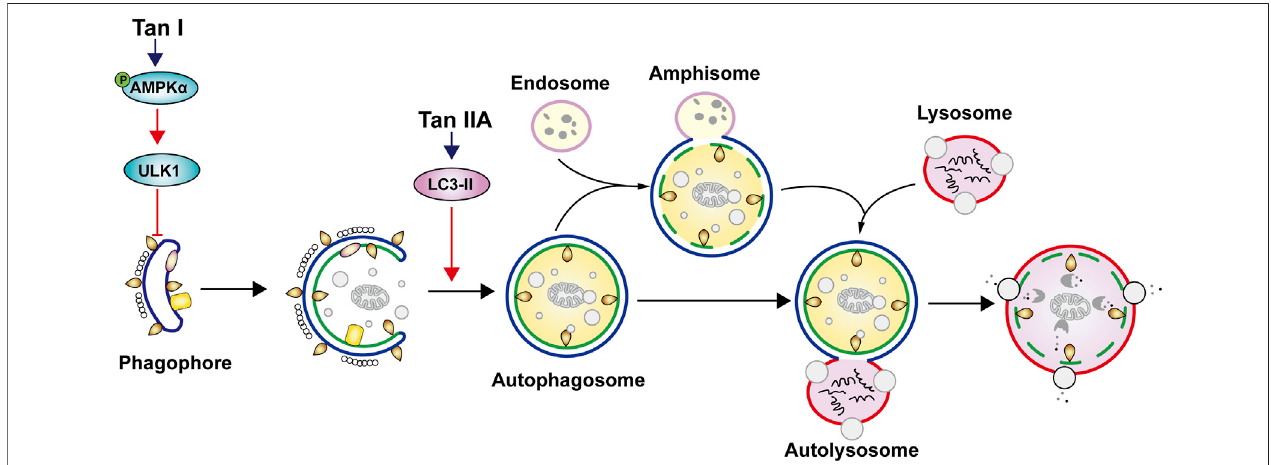
FIGURE 3 | Induction of autophagy by bioactive constituents in S. miltiorrhiza. Tan I induces autophagy by up-regulating phosphorylation of AMPK α and its downstream ULK1 expression. Tan IIA induces autophagy by activating LC3-II